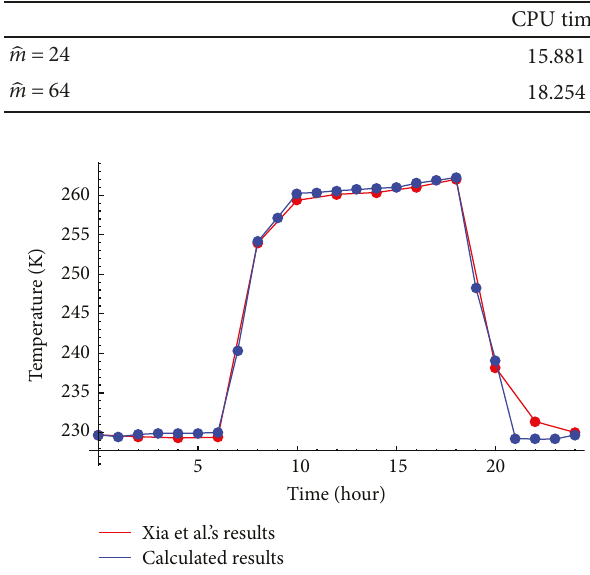
Figure 8: The comparison of day-night variation of helium temperature.